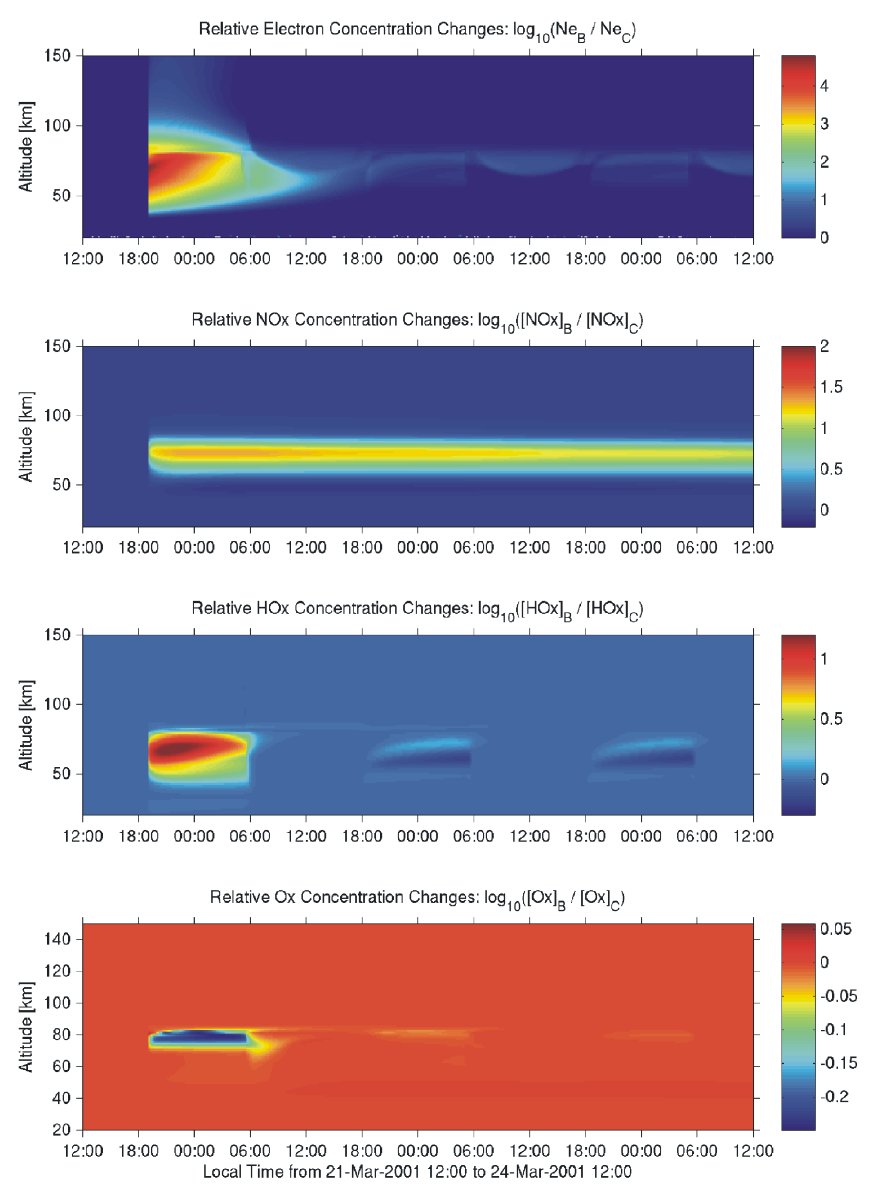
Fig. 7. The effect of the RBR-forced precipitation starting at 19 LT, to be contrasted with Fig. 5.